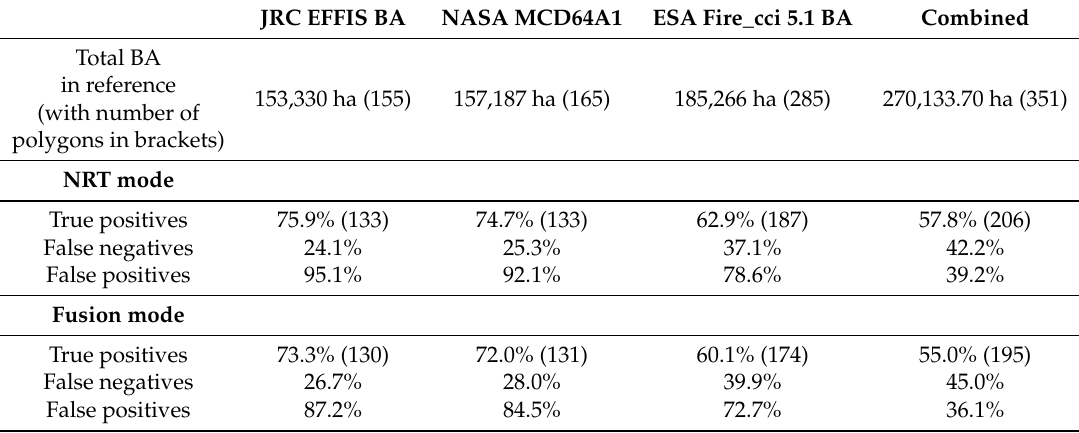
Figure 4. Burnt area results derived from Sentinel-3 OLCI data for Northern Portugal, for the testing period of August, 2017. The region highlighted by the ellipse illustrates that the algorithm correctly only reports burnt areas occurring within the predetermined time span. Background: NIR channel of a Sentinel-3 OLCI scene from end of August, 2017. Table 3. Large scale analysis: Comparison of Sentinel-3 OLCI results with reference